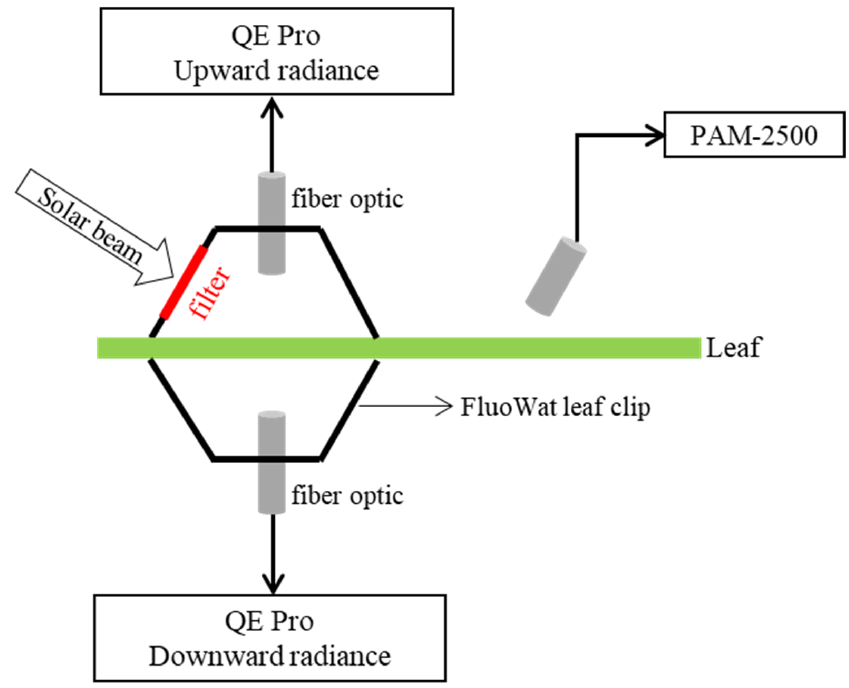
Figure 1. Scheme of measuring spectroscopy and PAM fluorescence on the leaf scale. A FluoWat leaf clip was used to measure reflectance (r), transmittance (t), and sun-induced fluorescence (SIF) in the visible and near-infrared wavelength range (350–1100 nm) by placing a fiber optic either in upward or downward position. After placing the shortpass to restrict incoming PAR to visible wavelengths up to 650 nm, upward and downward SIF are measured. A PAM-2500 fluorometer was used to measure active fluorescence near the clip.